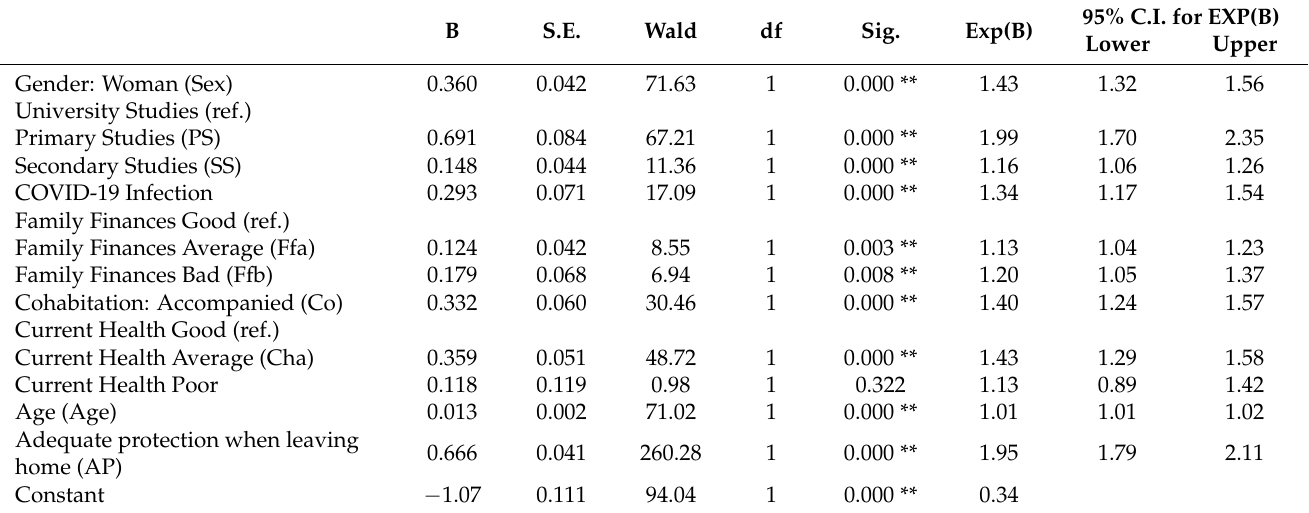
Table 3. Variables in the equation used in the regression analysis (likelihood of